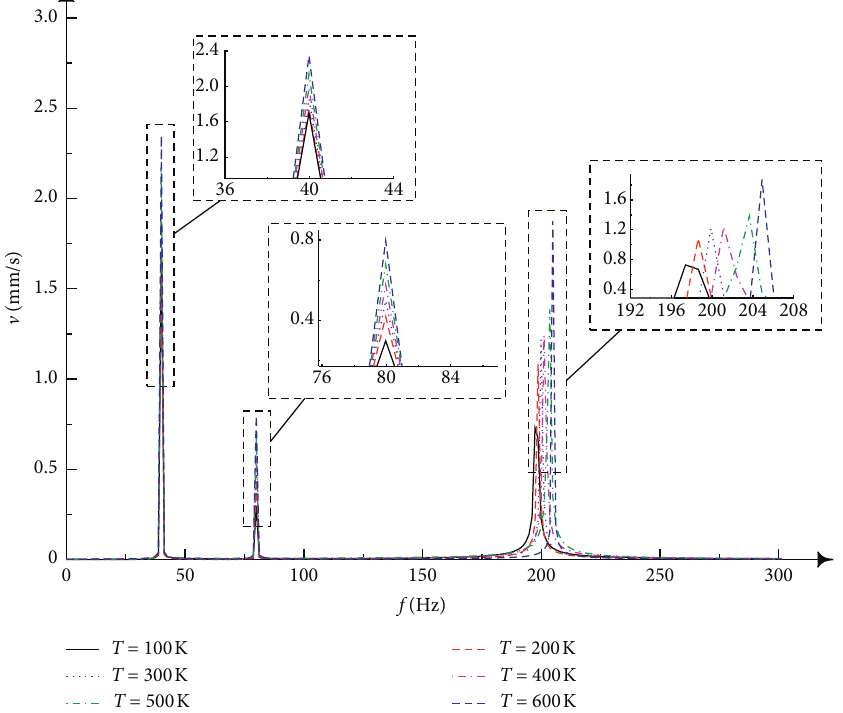
Figure 7: Frequency domain results for inner ring